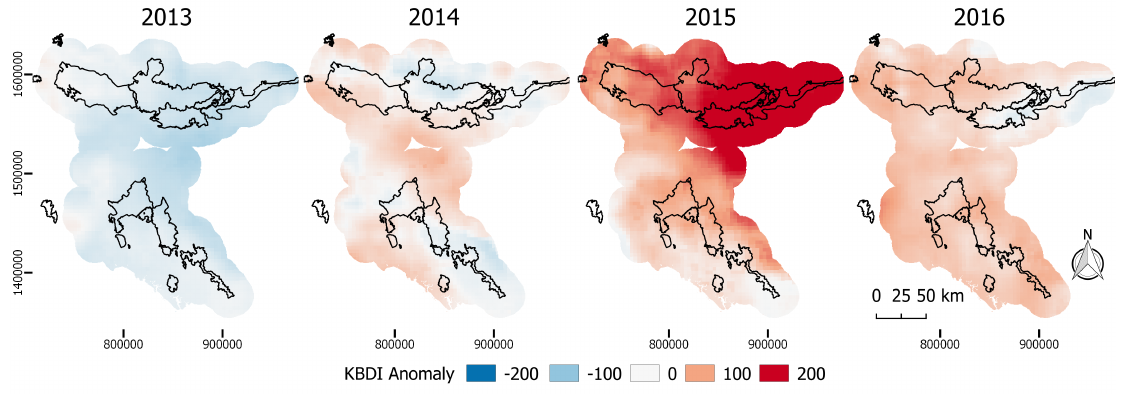
Figure 8. Anomaly of Keetch–Byram Drought Index (KBDI) showed large positive value in 2014–2016 compared to relatively normal condition in 2013. Positive KBDI anomaly indicated deficit of soil moisture, which is suspected to restrict the availability of resources and alter the potential HEC distribution.